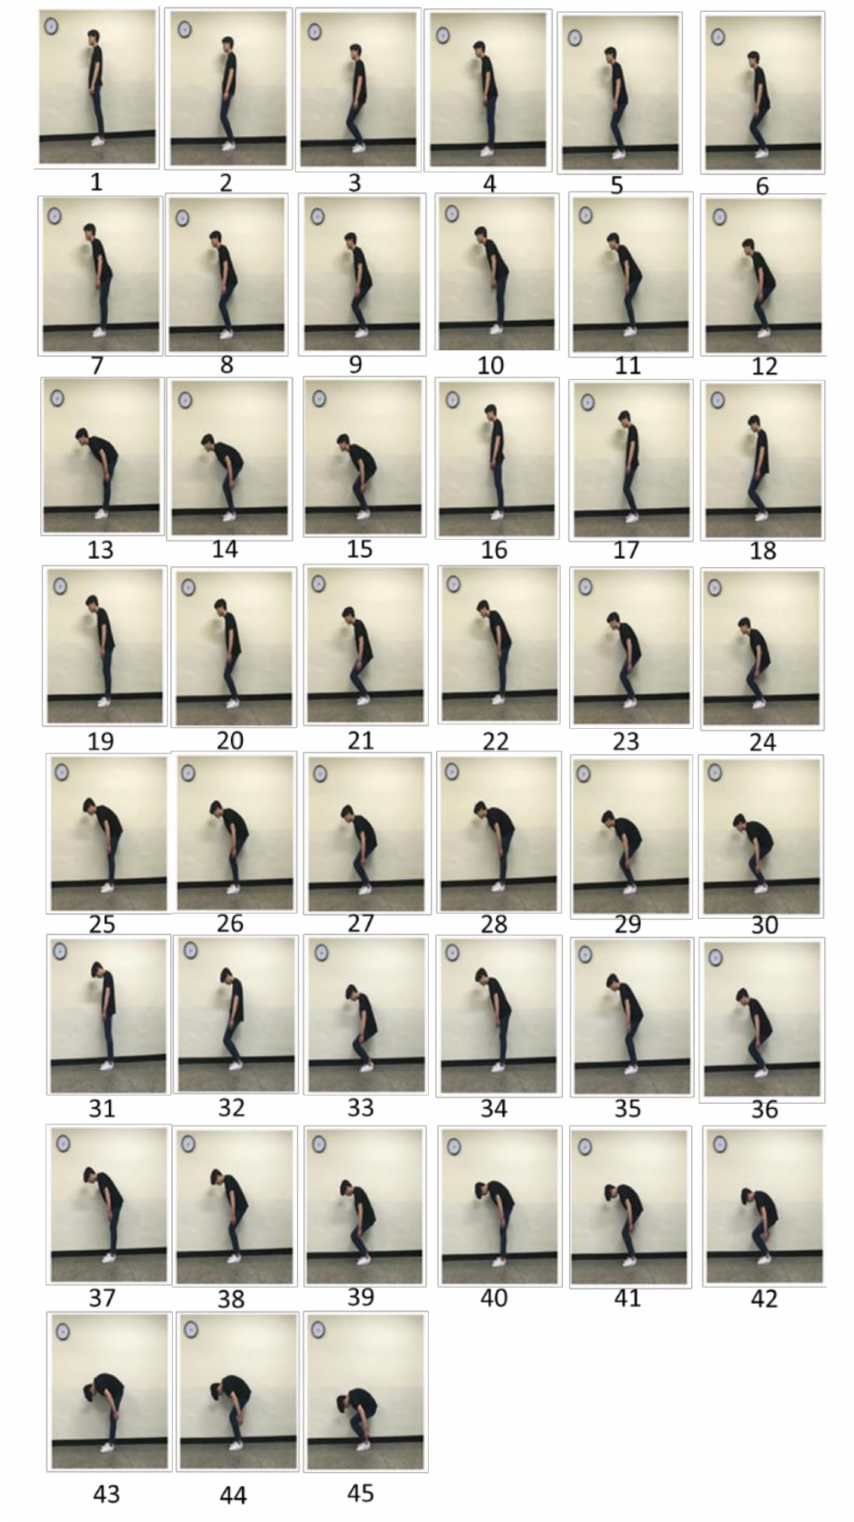
Figure 1. Examples of the 45 combined postures in terms of the neck flexion (0 ◦ , 20 ◦ , and 40 ◦ ), trunk flexion (0 ◦ , 20 ◦ , 40 ◦ , 60 ◦ , and 80 ◦ ), and knee flexion (0 ◦ , 30 ◦ , and 60 ◦ ) angles. The posture codes match with the description in Table